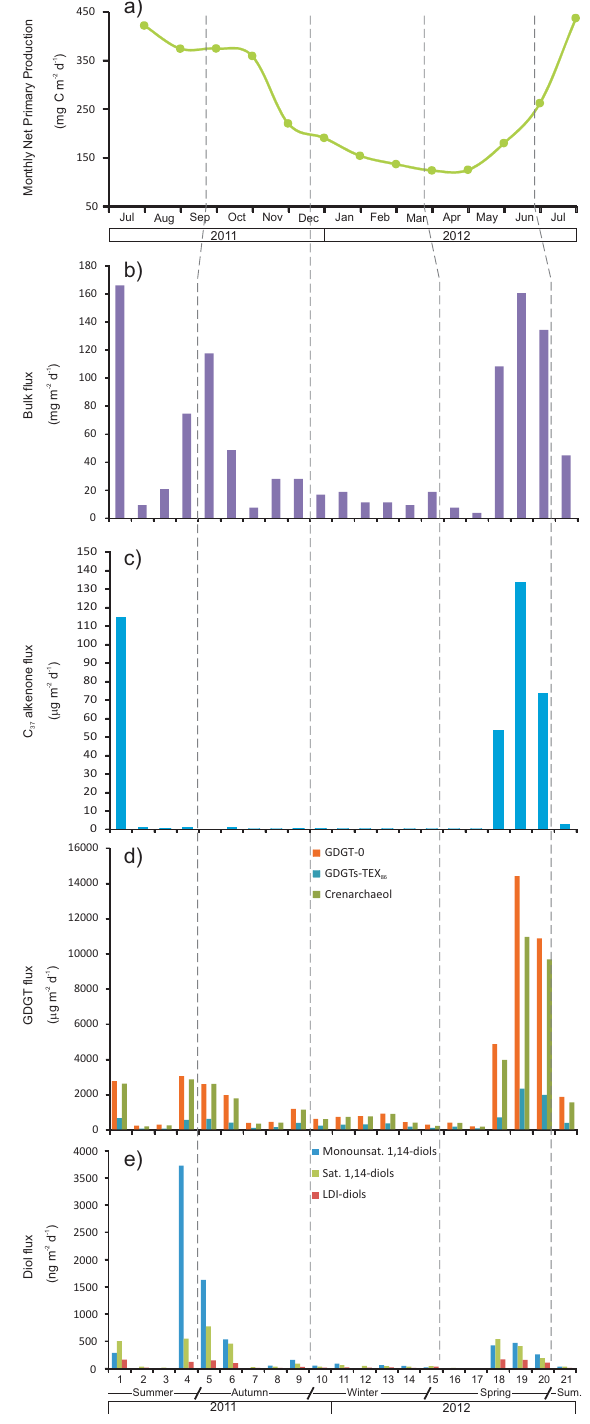
Figure 3. Panel (a) : variations in the net primary productivity from July 2011 to July 2012 derived from OceanColor Web (Behrenfeld and Falkowski, 1997). Bar plots of fluxes of (b) particulate matter, (c) C 37 alkenones, (d) isoprenoid GDGTs, and (e) long-chain diols as determined from sediment trap data. Numbers refer to sampling intervals specified in Table